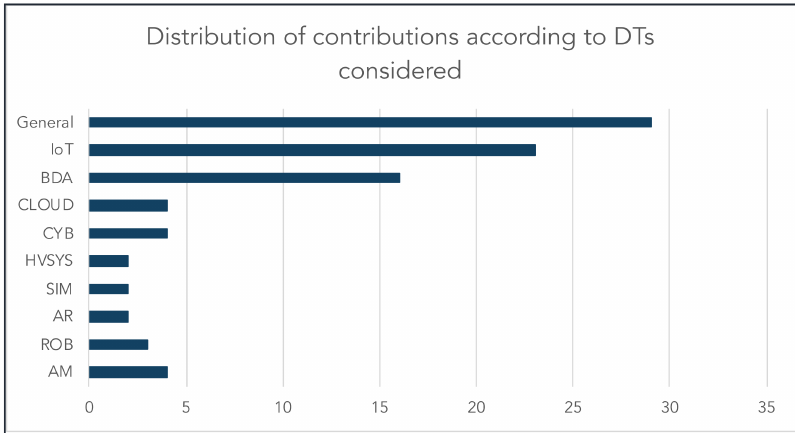
Figure 9. Distribution of the reviewed contributions according to DTs